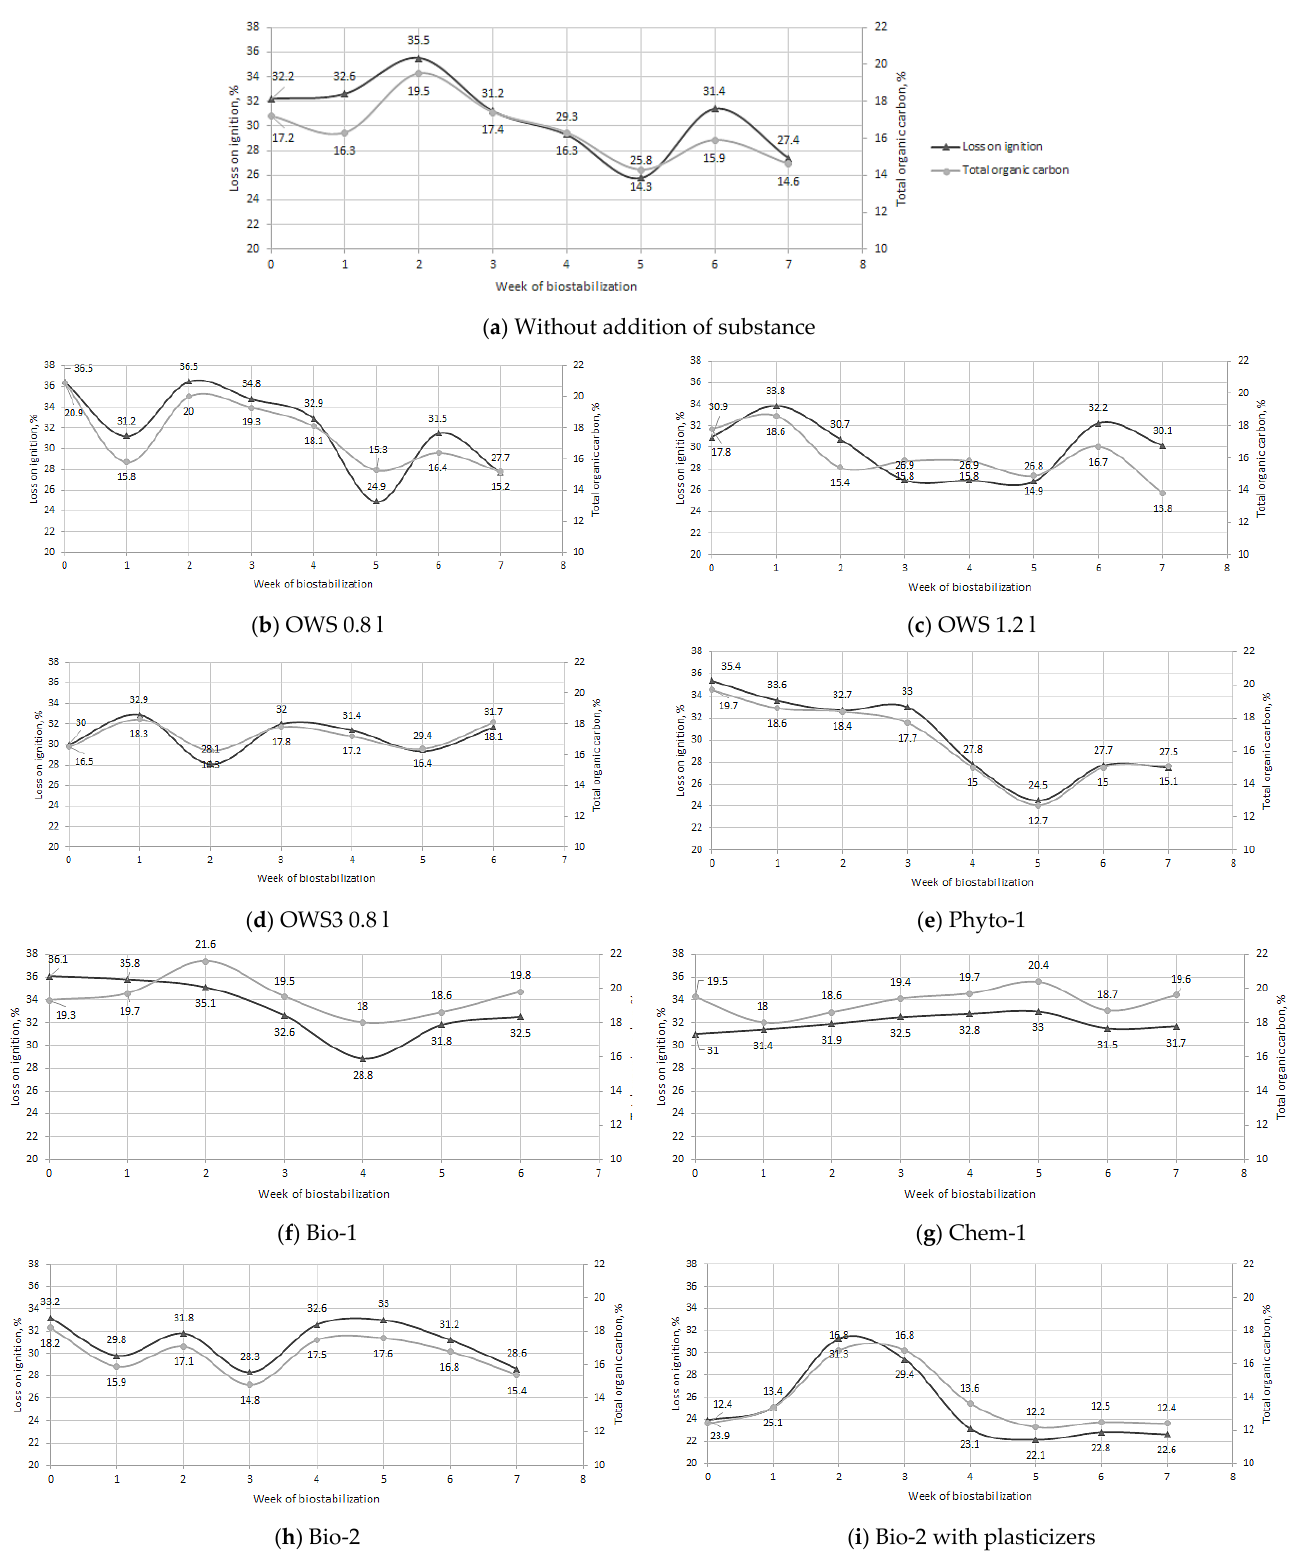
Figure 3. The dependence of loss on ignition and total organic carbon on the week of biostabilization. In most cases, the loss on ignition values ranged from 27.5% to 36.5%, while total organic carbon ranged from 14.6% to 21.6%. In the case of Bio-2 with plasticizers’ inoculation, the values were slightly lower, ranging from 22.6% to 31.3% (loss on ignition) and 12.4% to 16.8% (total organic carbon). In most cases the trend was downward and signif- icant fluctuations, apart from the variability resulting from the biostabilization phase, could have been due to the heterogeneity of sampling matrix.